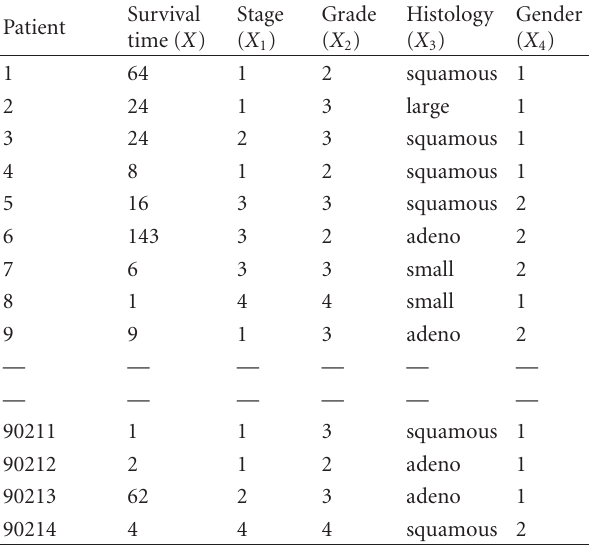
Table 2: A list of 128 combinations based on factor levels. Here, adeno, squamous, large, and small represent adenocarcinoma, squamous cell carcinoma, large cell carcinoma, and small cell carcinoma,